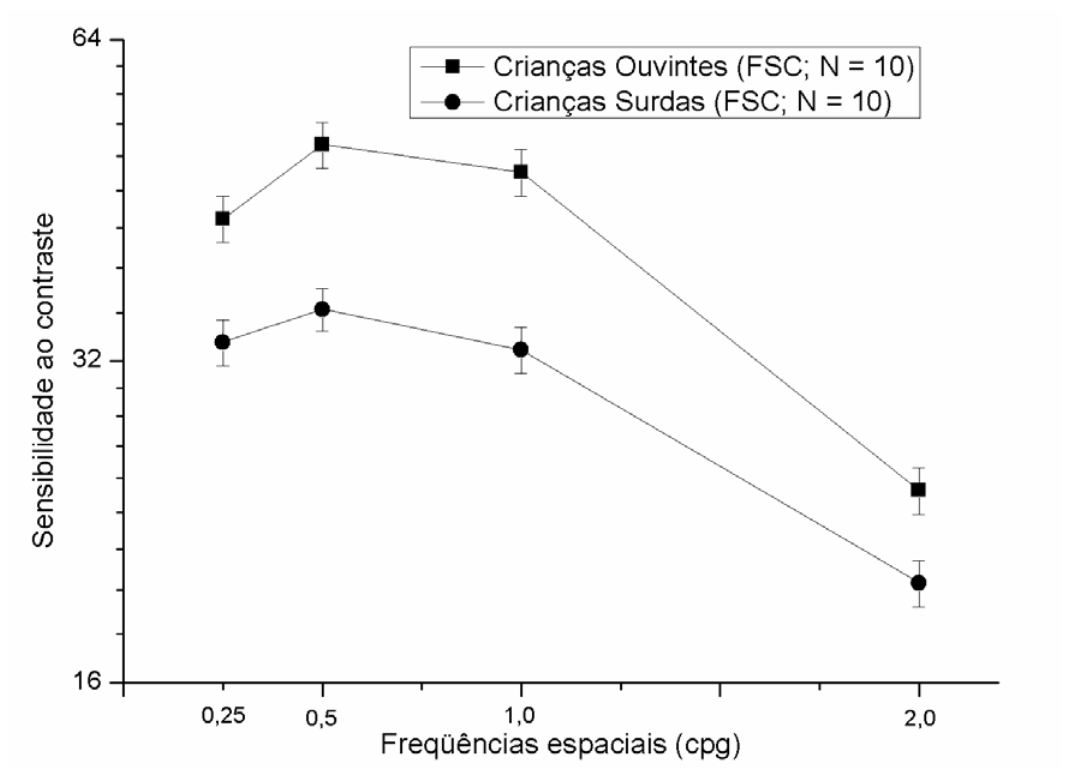
Figura 2 . Curvas de sensibilidade ao contraste para freqüências espaciais em crianças surdas ( ) e crianças com audição normal ( ), com idades entre 7 e 12 anos. As linhas verticais mostram o erro padrão da média para cada freqüência (0,25; 0,5; 1,0 e 2,0